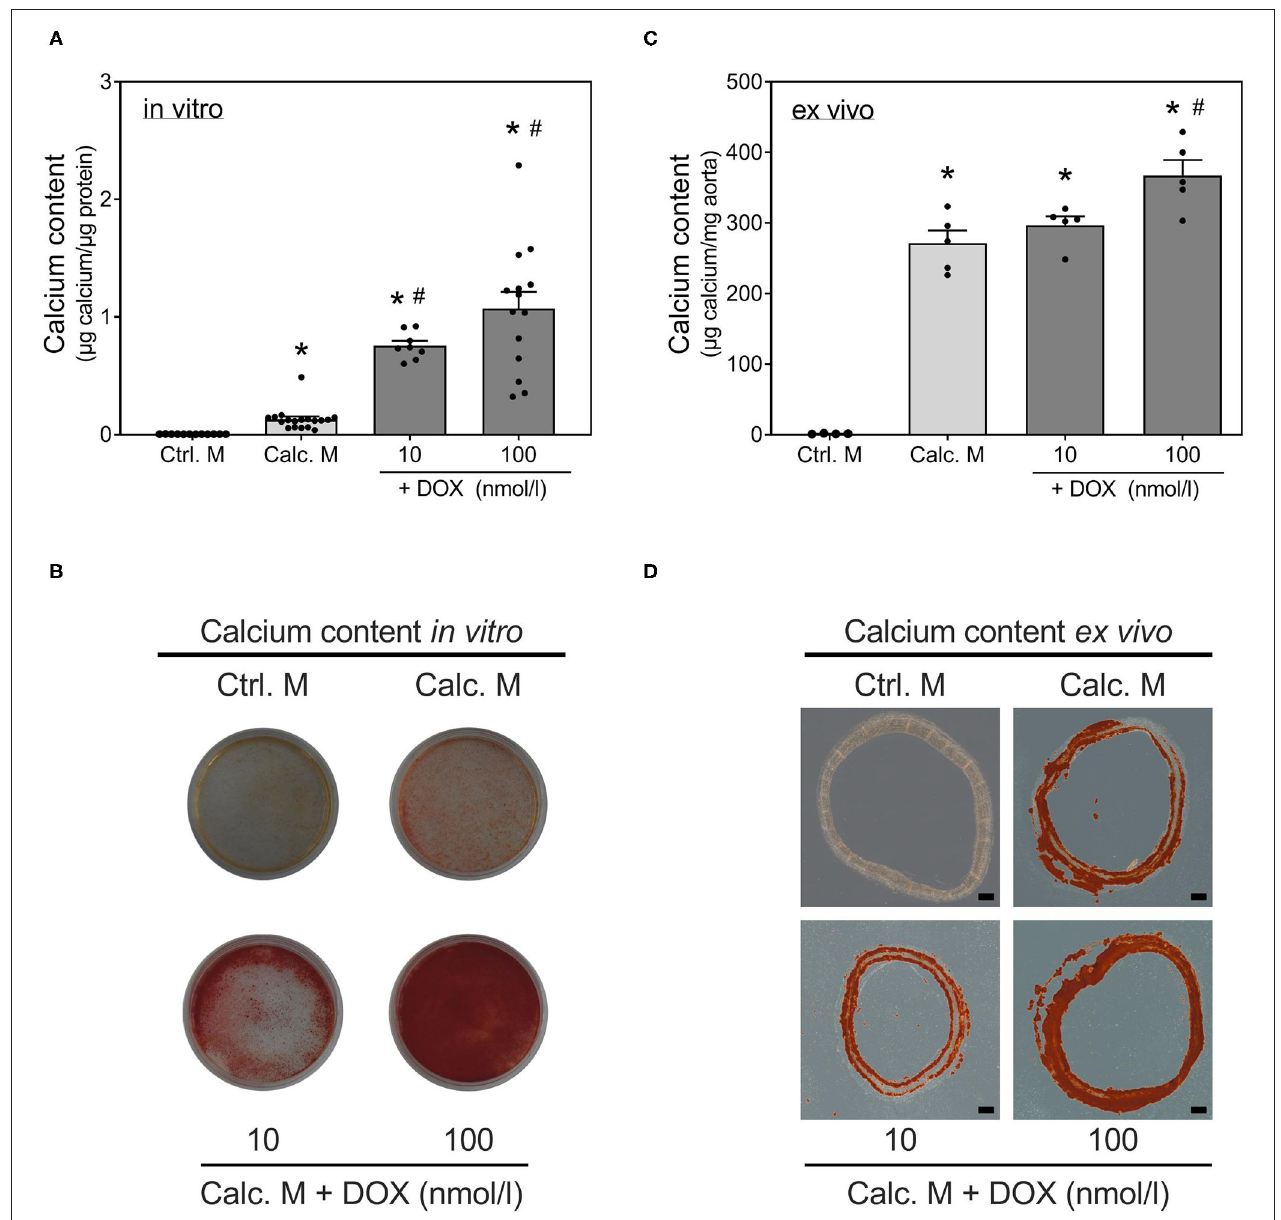
FIGURE 1 | Induction of calcification with doxorubicin. VSMCs (A,B) or rat aortic rings (C,D) were stimulated with control medium or calcification medium supplemented with DOX as indicated for 14 d. Calcium content was quantified with o-cresolphthalein (A,C) and normalized to protein content ( µ g) (A) or aortic weight (mg) (C) . Calcium deposits were stained with Alizarin Red (B,D) . Data represent mean ± SEM, n ≥ 3, * p < 0.05 vs. indicated control, # p < 0.05 vs. calcification medium. Pictures show one representative experiment of n ≥ 3 (B,D) , the scale bar indicates a 200 µ m section (D)